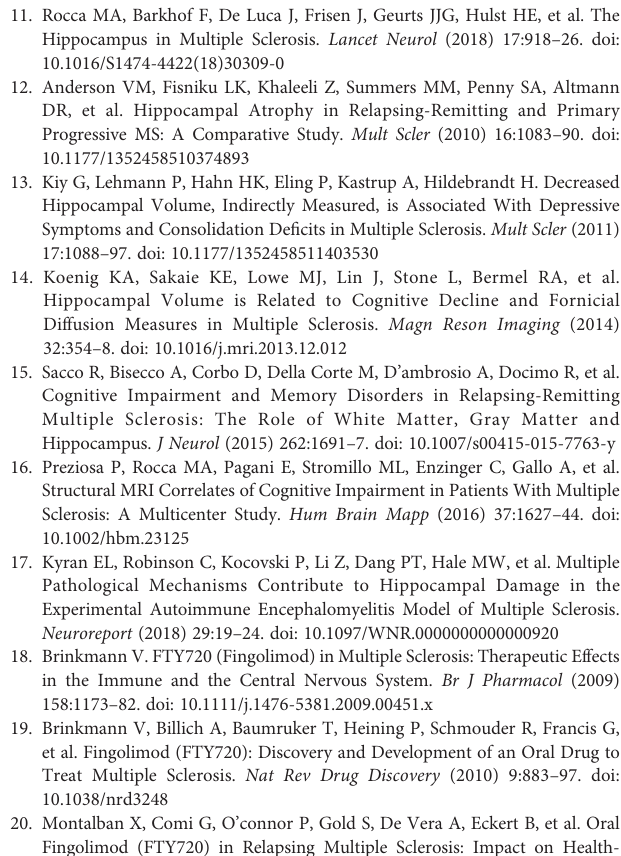
Supplementary Figure 4 | Absence of in fl ammatory in fi ltration along the neuraxis, at 9 dpi. The entire CNS was dissected from mice at 9 dpi and prepared for histology, as described under ‘ Materials and Methods ’ . Images (A – N) are all representative images from 9 dpi mice, with n = 3. Sections were cut at 7 µm at multiple levels along the neuraxis and HE stained. Regions shown in yellow boxes in (B, D, G, I, K, M) were selected based on our experience with spatio-temporal lesion development in EAE (17, 32, 33, 36, 38, 40, 42). They indicate white matter